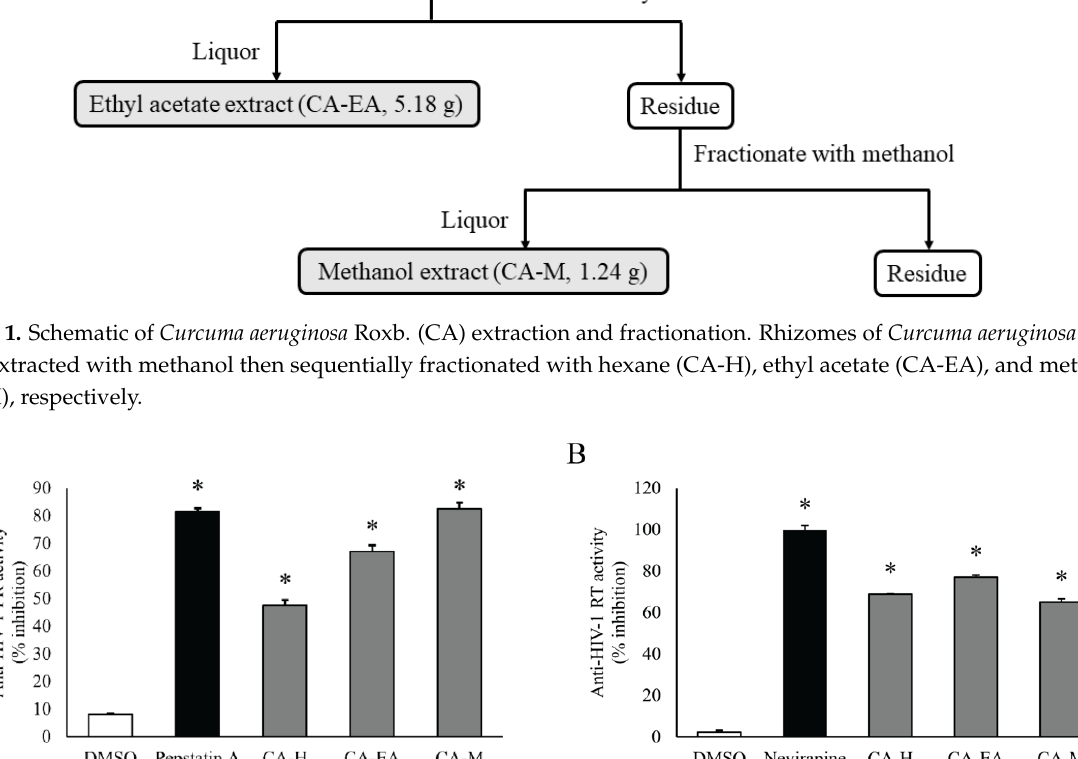
Figure 1. Schematic of Curcuma aeruginosa Roxb. (CA) extraction and fractionation. Rhizomes of Curcuma aeruginosa Roxb. were extracted with methanol then sequentially fractionated with hexane (CA-H), ethyl acetate (CA-EA), and methanol (CA-M), respectively.